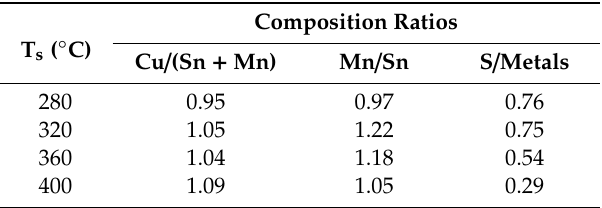
Table 2. Composition ratios of the CMTS thin films deposited at di ff erent substrate